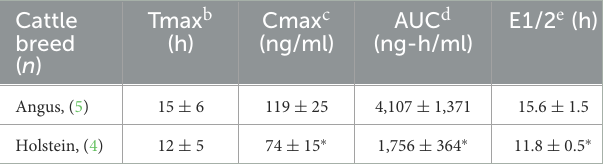
TABLE 1 Serum MLA toxicokinetic data for in Angus and Holstein orally dosed with 2.7 mg/kg MLA in the form of dried ground low larkspur ( D. andersonii a ) (37).